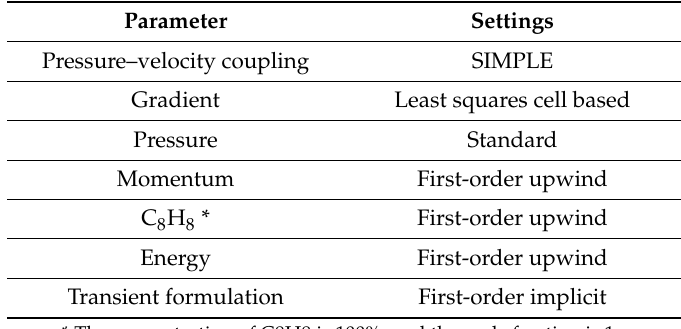
Table 3. Discretization settings.